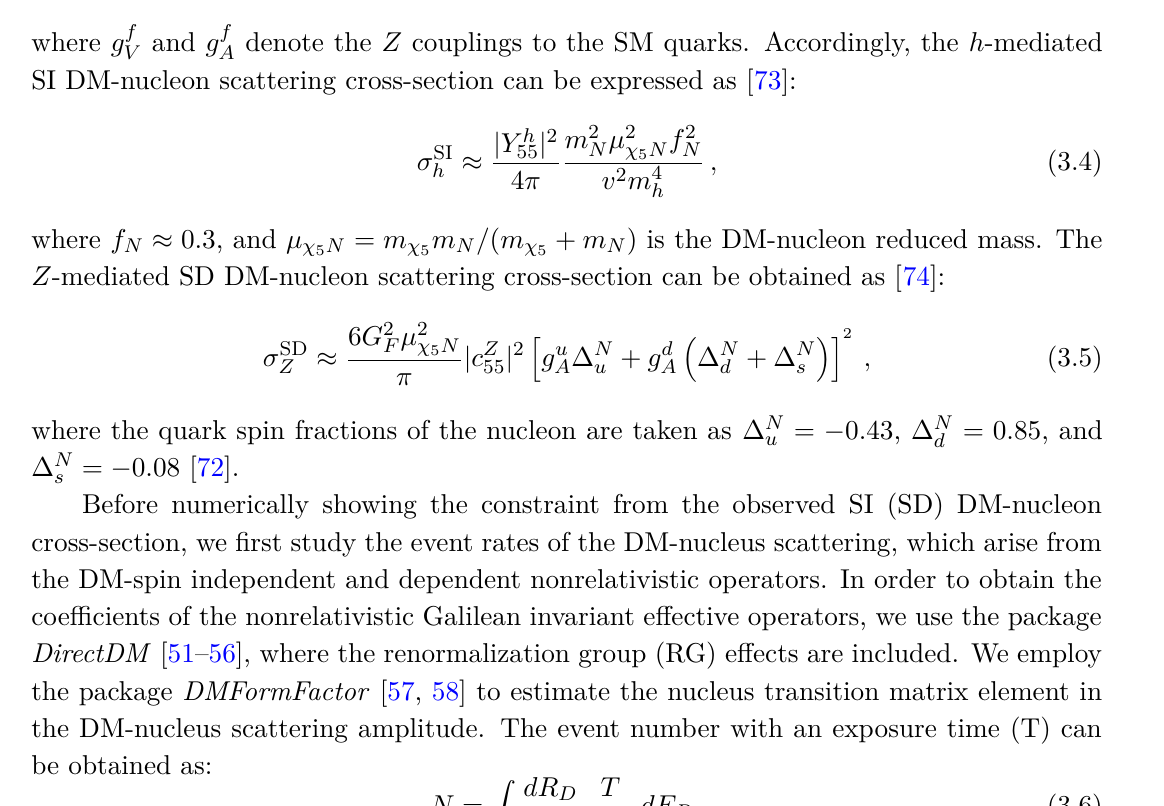
, where (a) h k = [ − 0 . 5 , 0 . 5] is used; (b) h 2 L 5 = (0 . 2 , 0 . 3 , 0 . 35) are shown by the dotted, dashed, and dash-dotted L